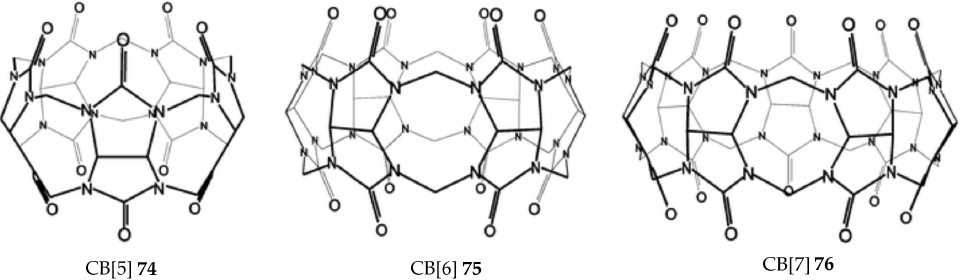
Figure 9. Structures of cucurbit[n]uril derivatives 74 – 76 .